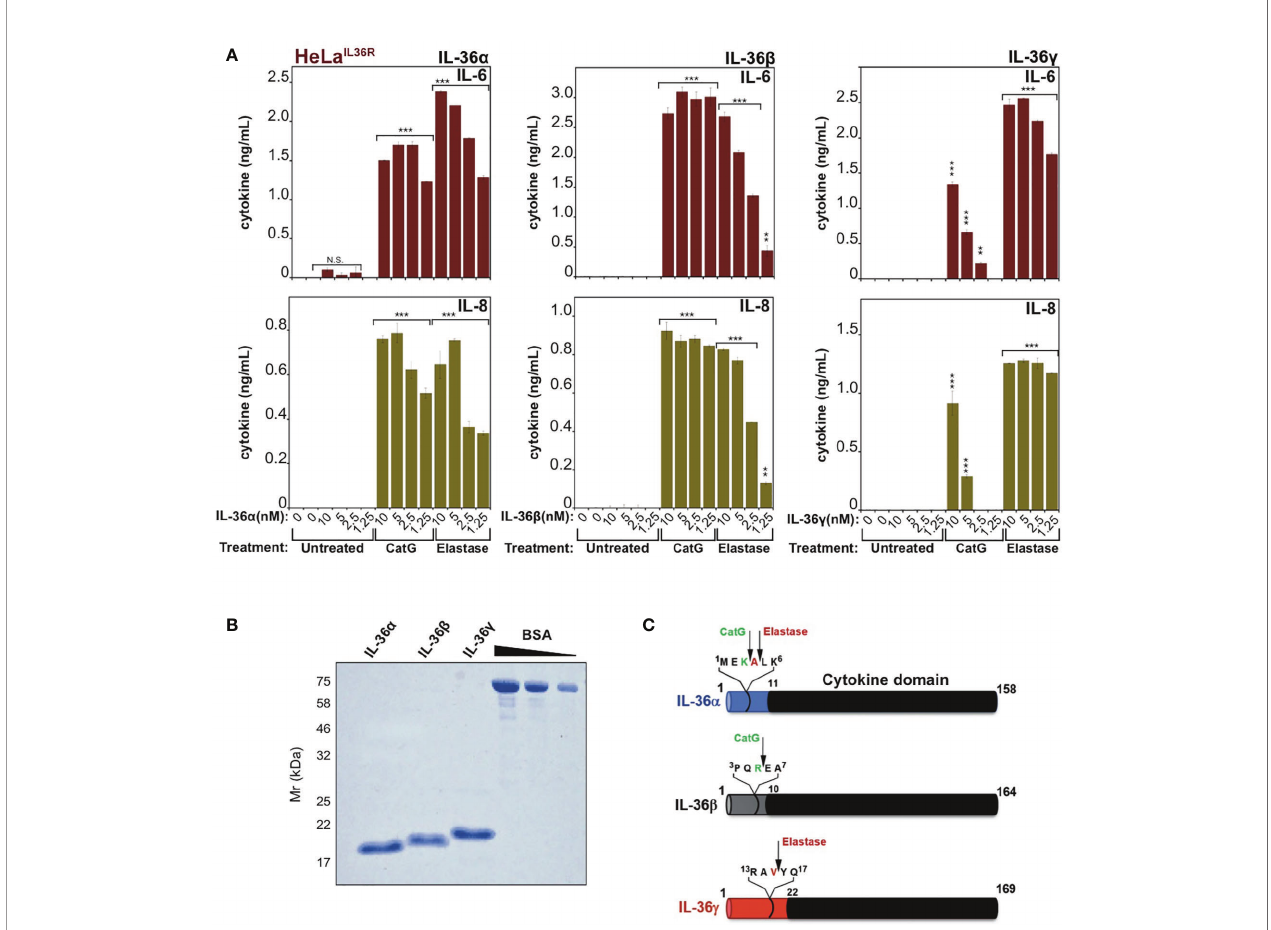
FIGURE 1 | IL-36 family cytokines require proteolytic processing for activation (A) HeLa IL-36R cells were stimulated with the indicated dose ranges of recombinant full-length human IL-36 a , IL-36 b or IL-36 g , that were pre-incubated for 2h at 37°C in the presence or absence of cathepsin G (50nM) or elastase (50nM), as indicated. After 24 h, IL-6 and IL-8 cytokine concentrations in cell culture supernatants were measured by ELISA. (B) Human recombinant full-length IL-36 a , IL-36 b and IL-36 g were puri fi ed as described in materials and methods and purity was assesed by SDS-PAGE followed by Coomassie blue staining. (C) Schematic representation of human IL-36 family cytokines with cleavage sites for elastase and cathepsin G indicated. Error bars represent the mean of triplicate determinations from representative experiments. ***p < 0.001, **p < 0.01, Student ’ s t test. N.S., Not Signi fi